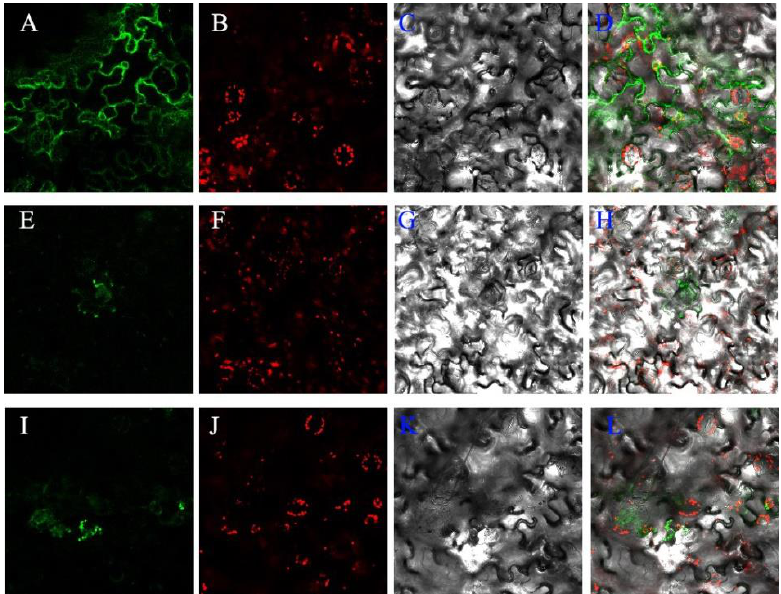
Figure 5. Subcellular localization of Xs GAO1 and Xs GAO2 fusion proteins in tobacco leaves. Im- ages show tobacco leaves transformed with ( A – D ) the 1300-GFP empty plasmid, ( E – H ) the 35S: GAO1-GFP plasmid, and ( I – L ) the 35S: GAO2-GFP plasmid under various lights. Green signals correspond to the target gene fused with green fluorescent protein (GFP) after excitation at 488 nm; red signals correspond to the chloroplasts’ autofluorescence after excitation at 488 nm.